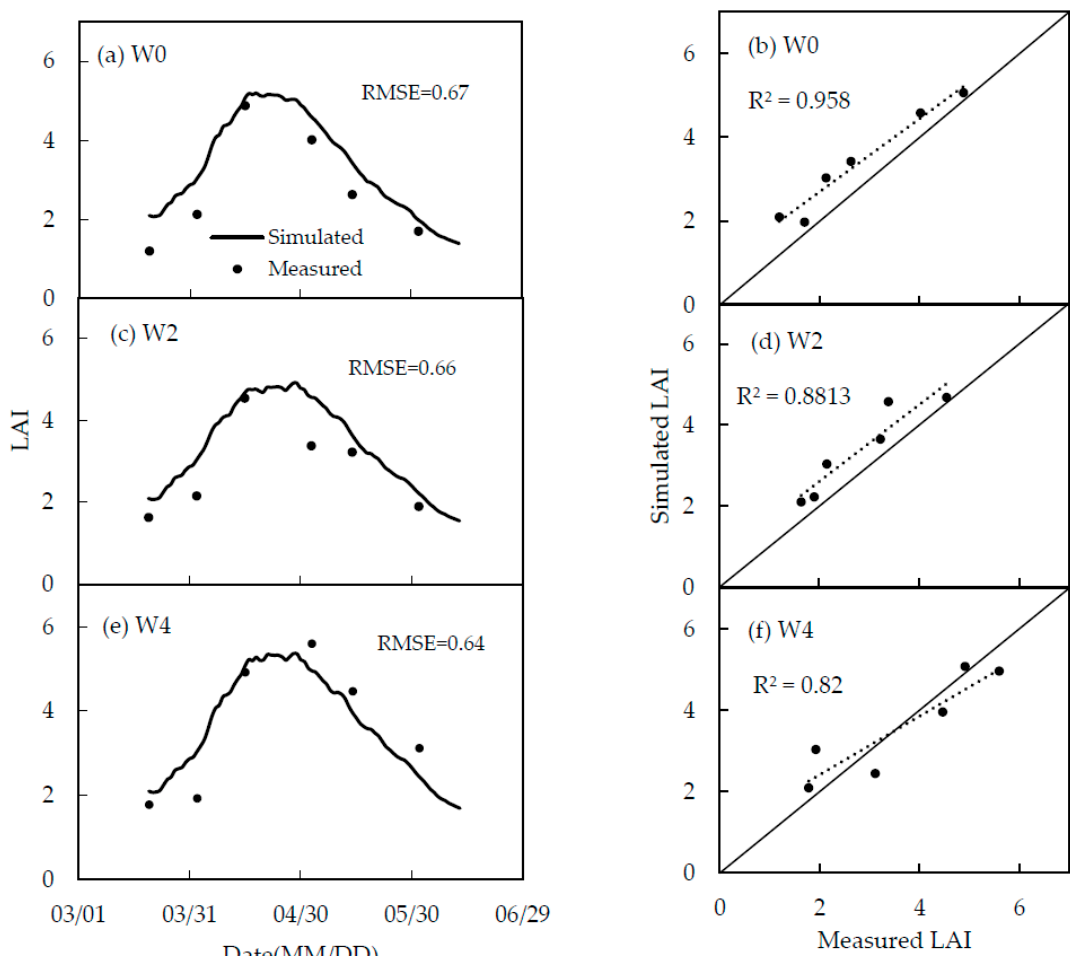
Figure 12. Comparison of simulated and measured LAI in calibration treatments.